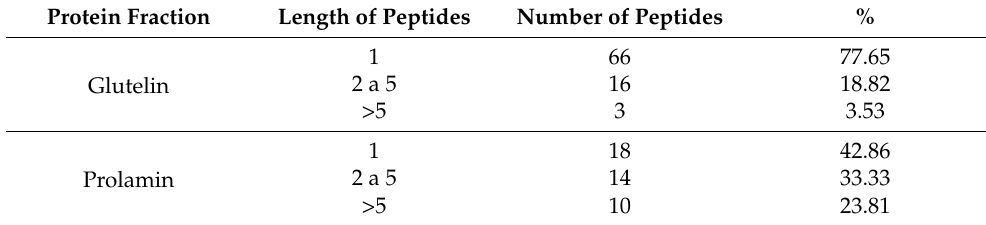
Table 2. In silico hydrolysis of the glutelin and prolamin proteins of rice ( Oryza sativa ). Protein Fraction